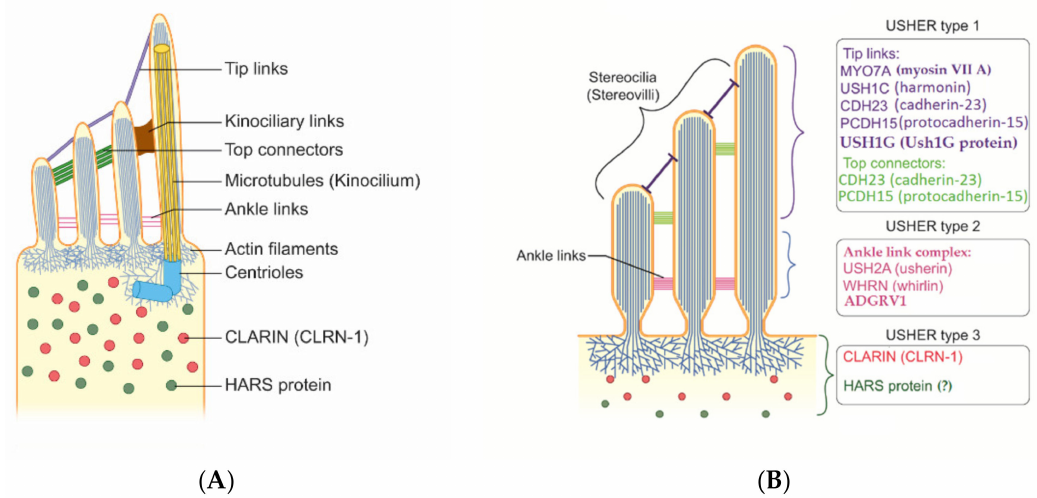
Figure 2. Simplified and schematic representation of structures, genes, and proteins involved in Usher syndrome. ( A ) The picture shows the main structures of a sensorineural inner ear cell. ( B ) Different genes and proteins have been identified, some responsible for different USH subtypes. It should be noted that clarin-1 protein (in red) is a four-transmembrane protein that is synthetized and collected in the cytosol and then moves to cellular membrane during maturation processes; in the membranes, clarin protein acts as a modulator of mechano-transduction. In the figure, clarin-1 is intentionally pictured inside the cytosol to keep it separated from other proteins. Hars protein (in dark green) is a cytoplasmatic enzyme. The role of HARS1 gene in USH type 3 must be confirmed. HARS protein = histidine–tRNA ligase, cytoplasmic. Even if is not reported in the figure, myosin 7A seems to also interact with proteins of the ankle link